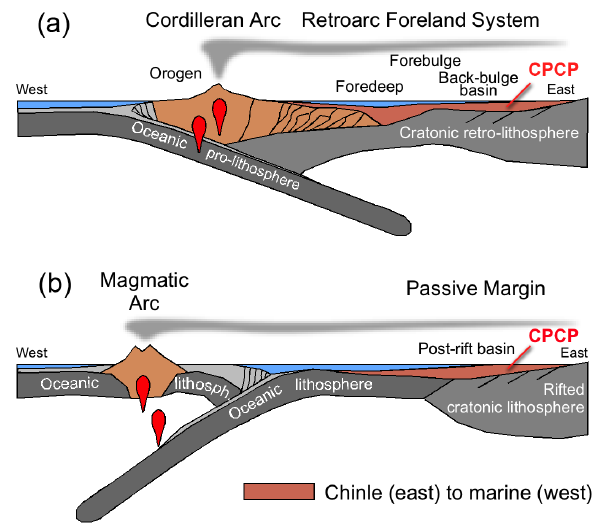
Figure 3. Generalized cartoons of end-members of the alterna- tive tectonic models for the Chinle basin (at position of CPCP in red). (a) Conventional model of a Triassic Cordilleran arc with a retroarc basin with Chinle and marine strata (modified and general- ized from Eriksson et al., 2008; DeCelles and Giles, 1996). (b) Pas- sive margin model for Triassic western North America (modified from Chemenda et al., 1997) which is consistent with Hildebrand (2013). Note that realistic, empirically based cross sections for these end-member models have yet to be published and that these are car- toons based on possible analog situations, with the additional caveat that the significant possibility of large strike–slip components (non- plane strain) is not addressed in this figure. Note also that Chinle was probably in a belt of easterly (trade) winds at the